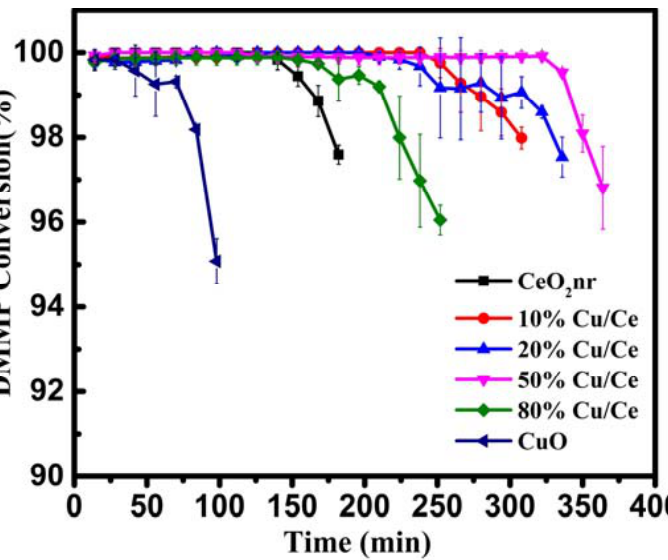
Figure 11. Effects of different Cu/Ce ratios of the CeO 2 ‐ supported CuO catalysts on protection time. Reaction temperature, 400 °C; inlet DMMP concentration, 8.46 g/m 3 ; catalyst weight, 0.46 g CuO/CeO 2 catalysts; size, 20–40 mesh; and GHSV, 20,000 h − 1 . Table 5. A comparison of protection time on various catalysts.